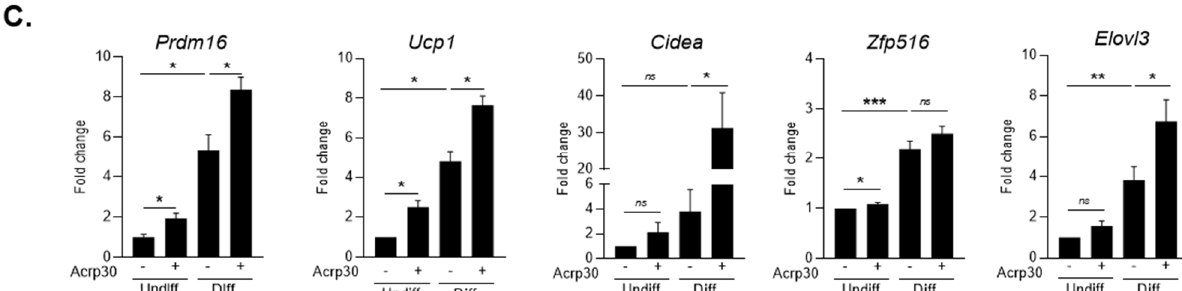
Figure 5. The effect of Acrp30 (adiponectin) treatment in undifferentiated and differentiated 3T3-L1 adipocyte cells. ( A ) Adipocyte differentiation and lipid accumulation by Oil red O staining, ( B ) protein expression related to adipocyte differentiation, ( C ) mRNA expression of genes involved in body fat browning. Means ± S.E. tested by independent t -test (nonparametric). * p < 0.05, ** p < 0.01, *** p < 0.001, n.s.: no significance; 20 ng/mL treatment of Arp30; undiff: undifferentiated cells, diff: differentiated cells.